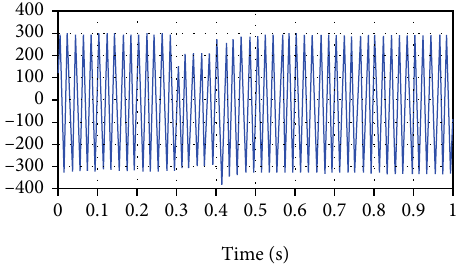
Figure 16: Voltage v compensation.